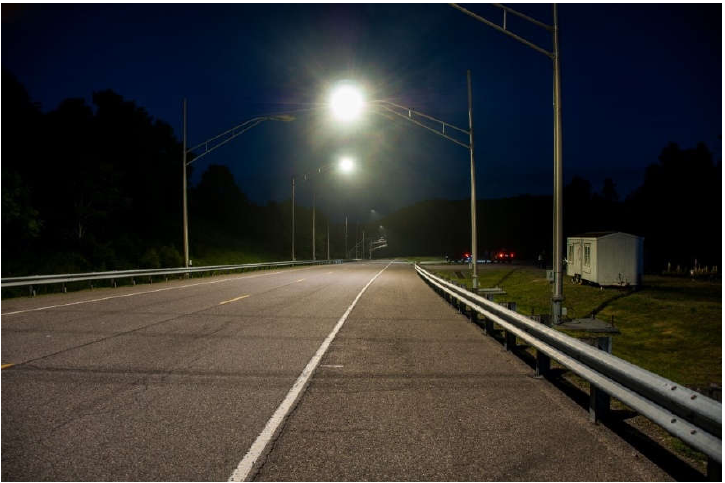
Figure 13. Smart Road Driving Facility.